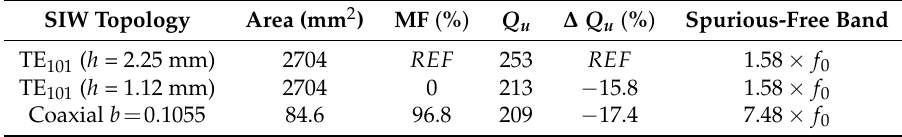
Table 2. Comparison of coaxial SIW topology versus standard TE 101 -based SIW topology.